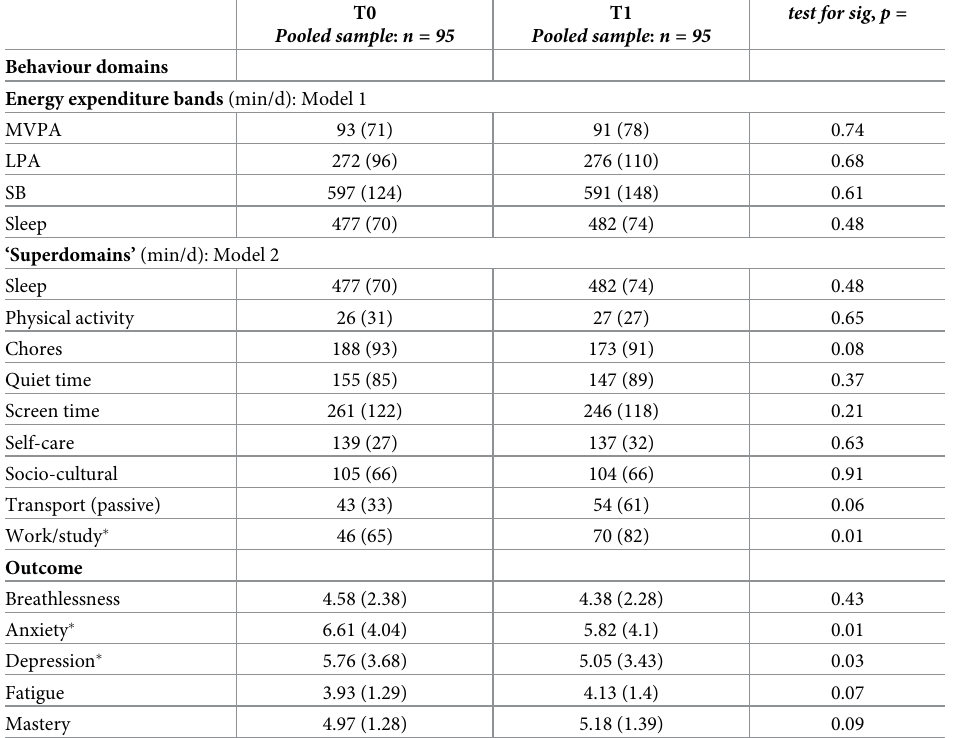
Table 3. Time spent in movement behaviours, symptoms and health-related quality of life at T0 and T1 assess- ment points.